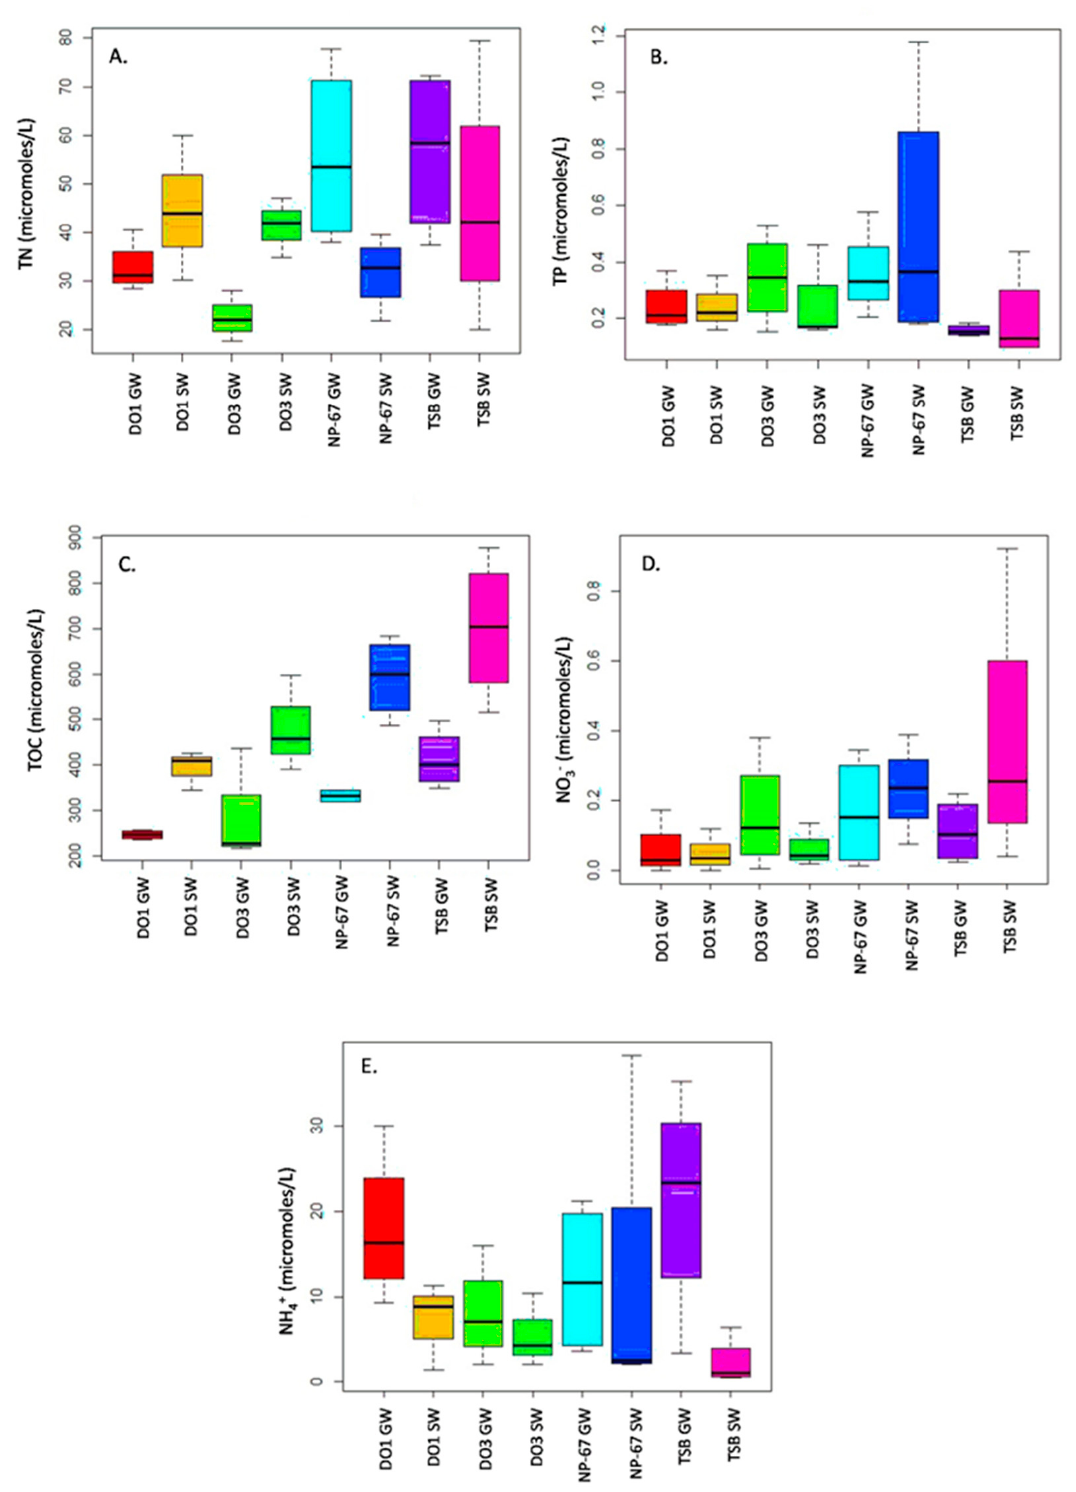
Figure 5. Box-and-whisker plots of nutrients from groundwater (GW) and surface water (SW) inside (DO1, DO3) and outside (NP-67, TSB) the HID: ( A ) TN; ( B ) TP; ( C ) TOC; ( D ) NO 3 − ; ( E ) NH 4+ (Source [42]).